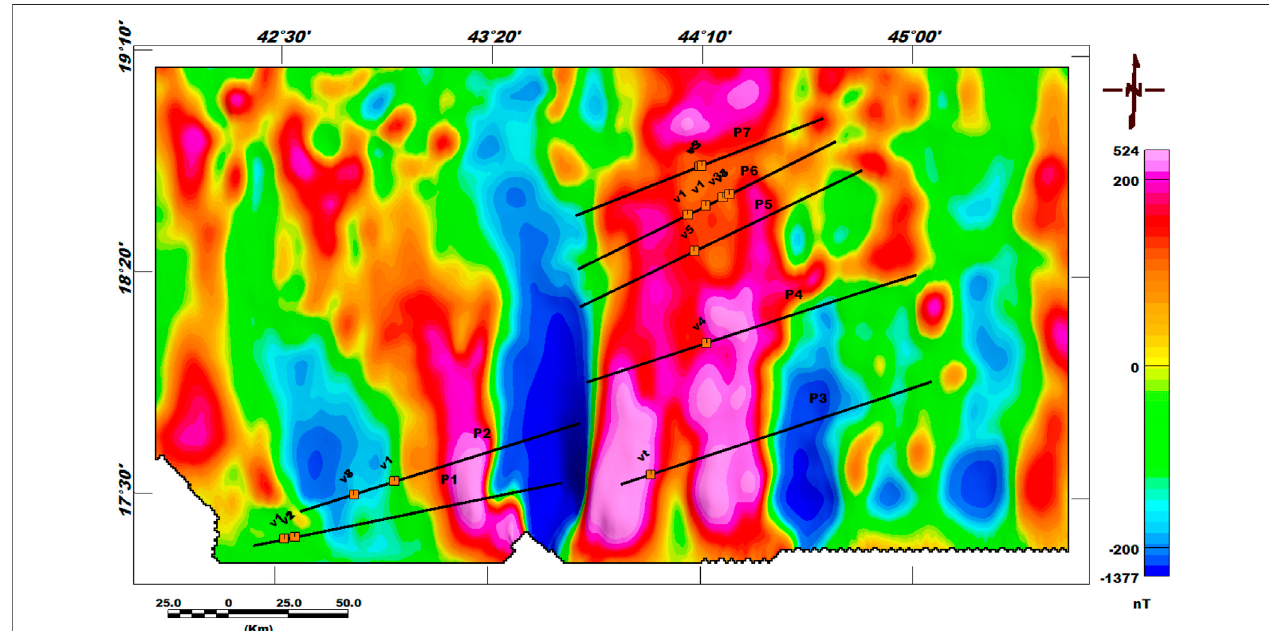
FIGURE 2 | The RTP map of the study area shows the locations of the 2D pro fi les and the Vertical Electrical Soundings.